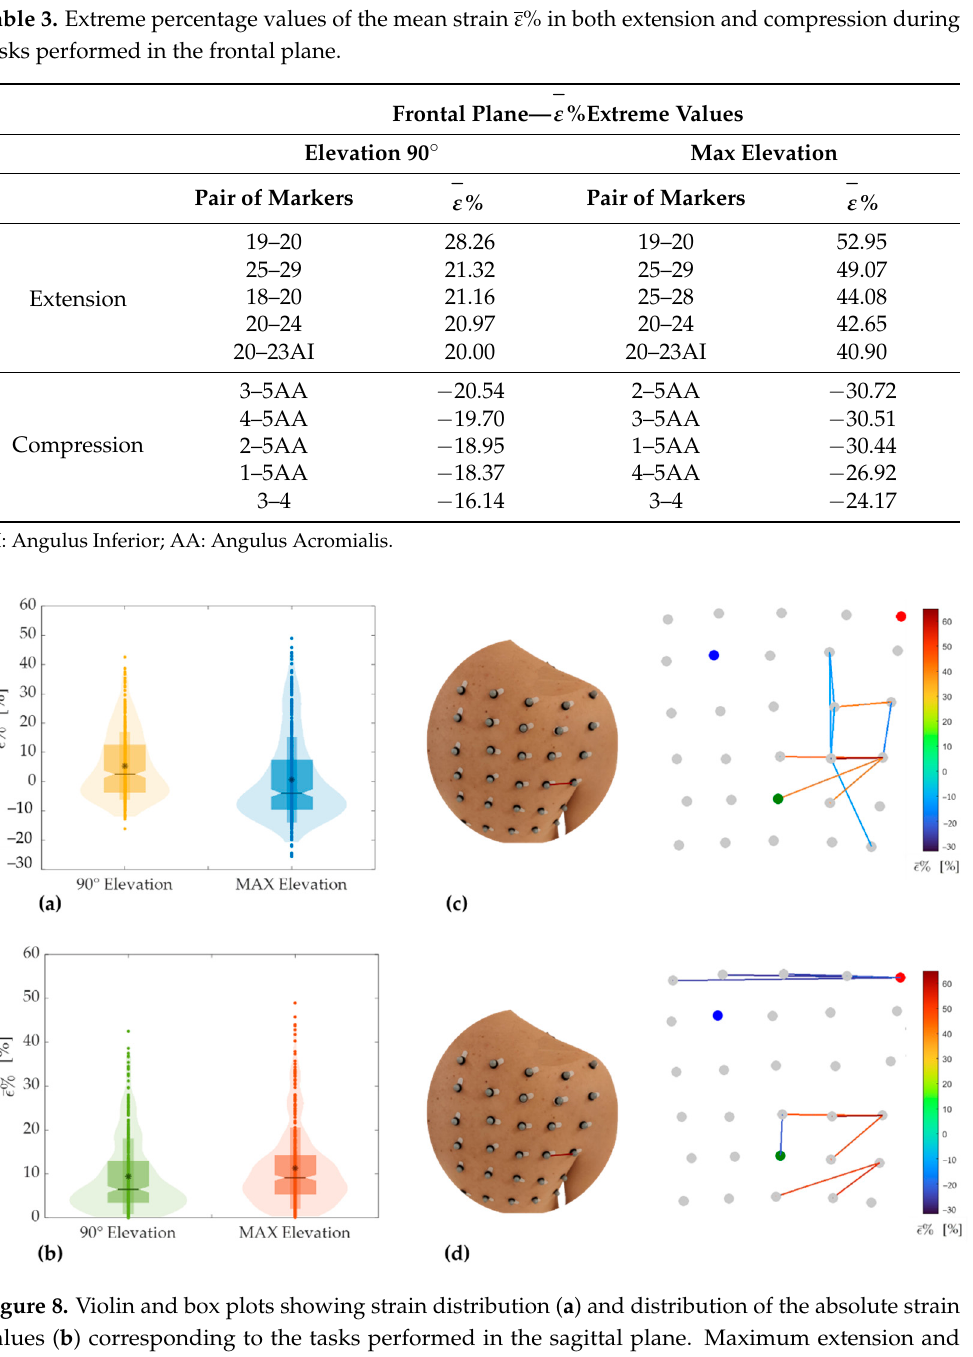
Table 3. Extreme percentage values of the mean strain 𝜀̅% in both extension and compression dur- ing tasks performed in the frontal plane.